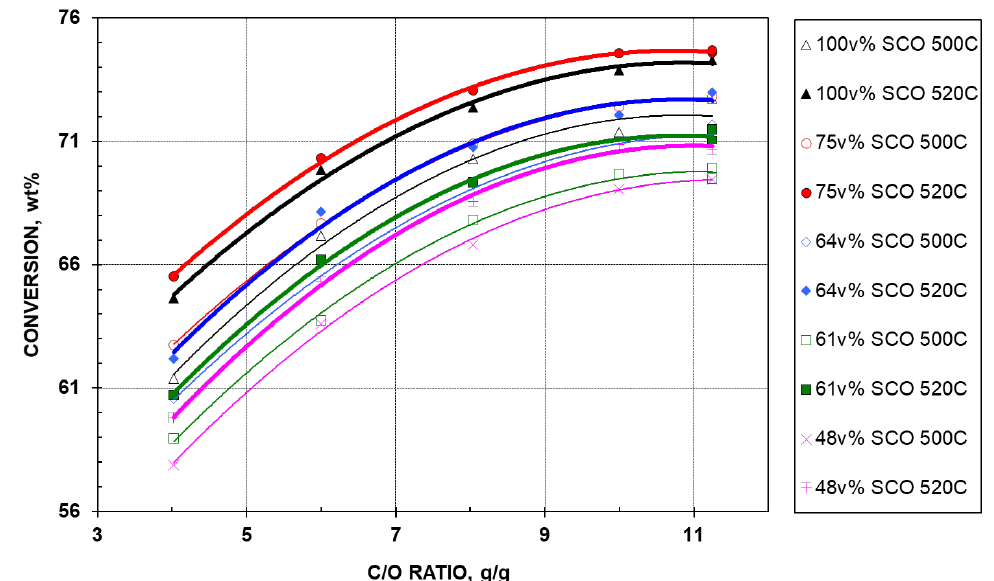
Figure 1. Conversion of SCO HGO and its blends with bitumen HGO vs. C / O ratio at two reaction temperatures.